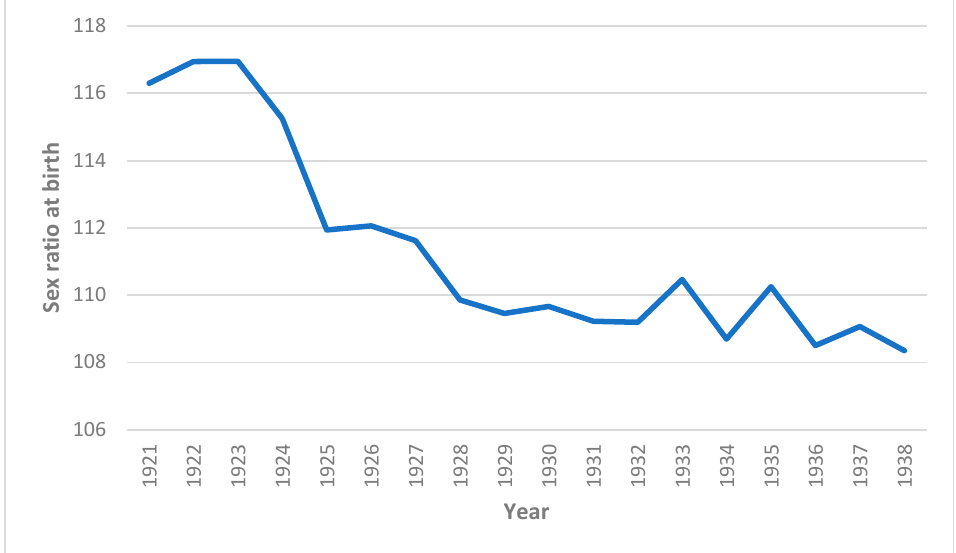
Figure 2. Sex ratio at birth (SRB). Greece 1921–1938. Source: Ministère de l’ Economie Nationale- Direction de la Statistique (1924, 1927, 1928a, 1928b, 1929, 1930a, 1930b, 1931a, 1931b, 1939).